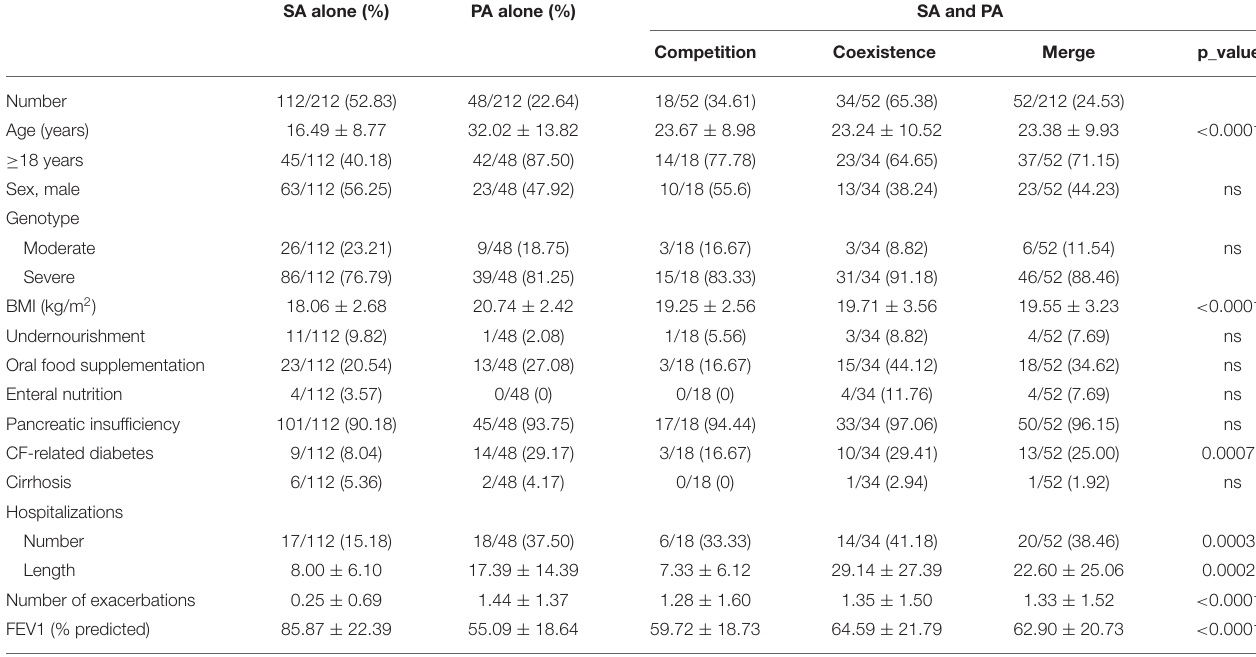
TABLE 1 | Clinical characteristics of CF patients according to their bacteriological status. SA alone (%) PA alone